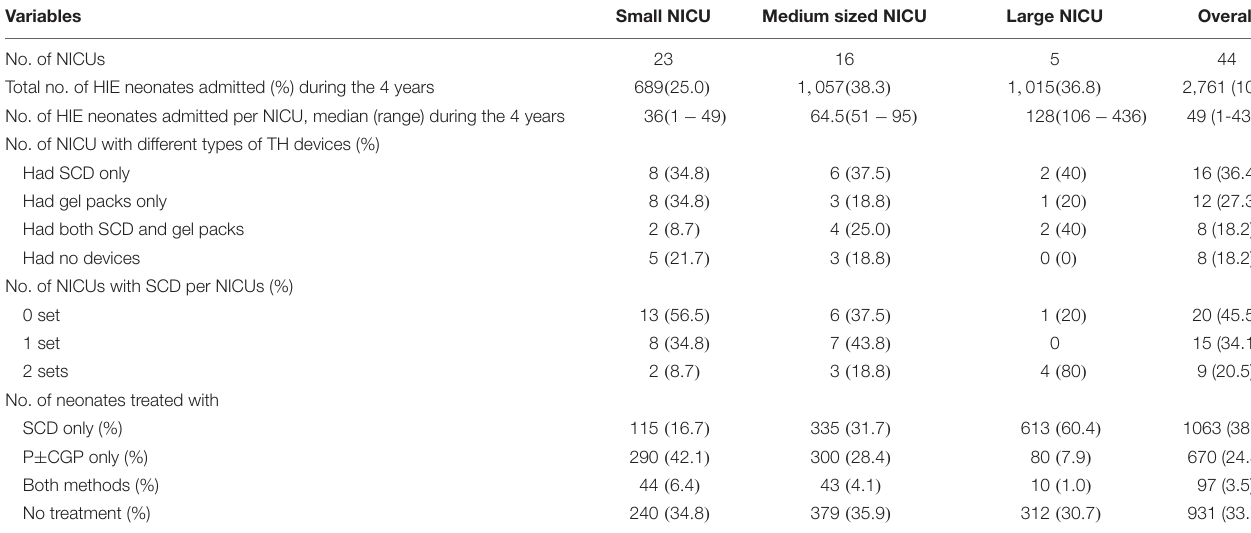
TABLE 2 | Frequency distribution of cooling devices and number of neonates with hypoxic ischemic encephalopathy in different types of neonatal intensive care units (NICUs), 2016–2019. Variables Small NICU Medium sized NICU Large NICU Overall